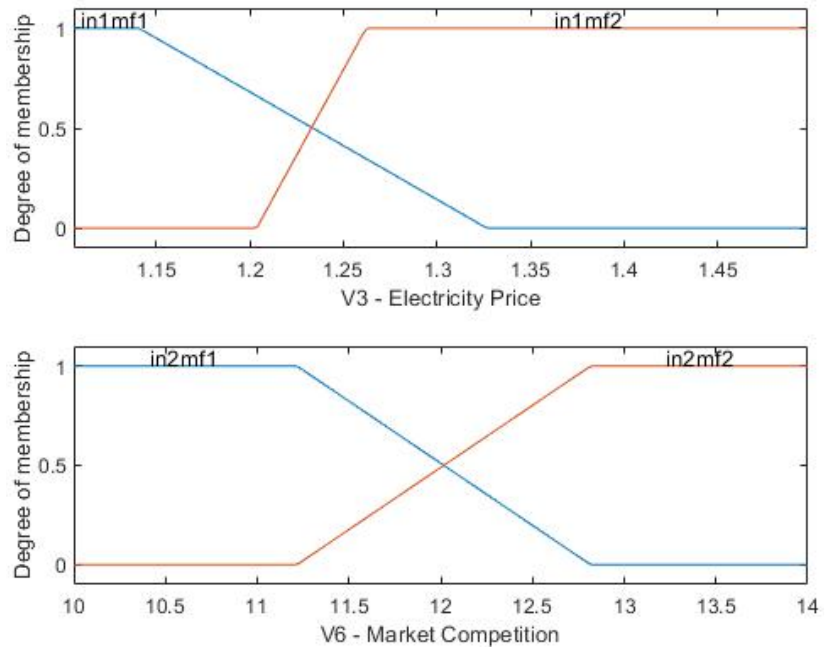
Figure 7. Error measurement for training and validation for demand forecasting.